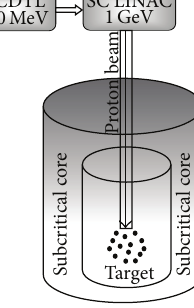
Figure 1: Layout of the 1 GeV LINAC for ADS (IS: ion source; RFQ: radio frequency quadrupol; DTL: drift tube LINAC; CCDTL: cavity coupled DTL; SC LINAC: superconducting linear accelerator).